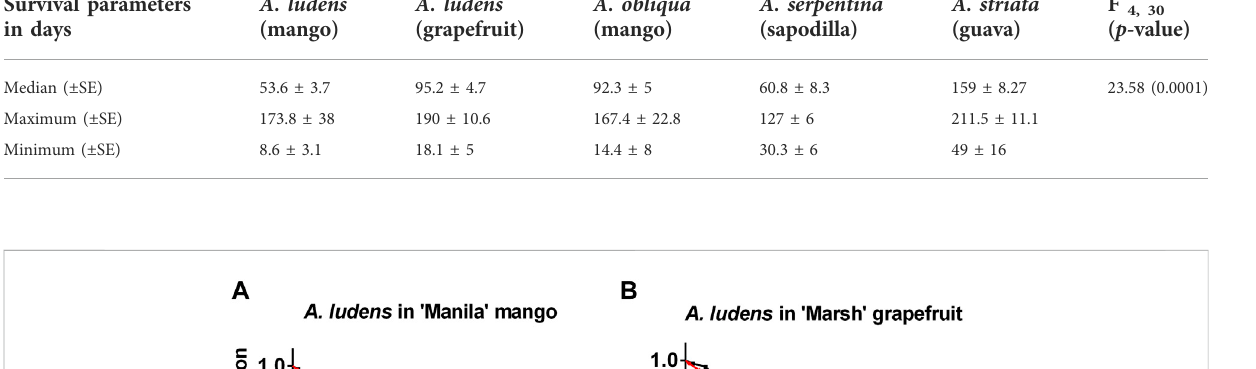
observed in fl ies that developed in mango (Table 3, Figure 7). We found a statistically clear difference between the lifespan of males and females in all the studied species (Figure 6); all hazard ratios comparing survival curves show that females lived less than males in the fi eld.